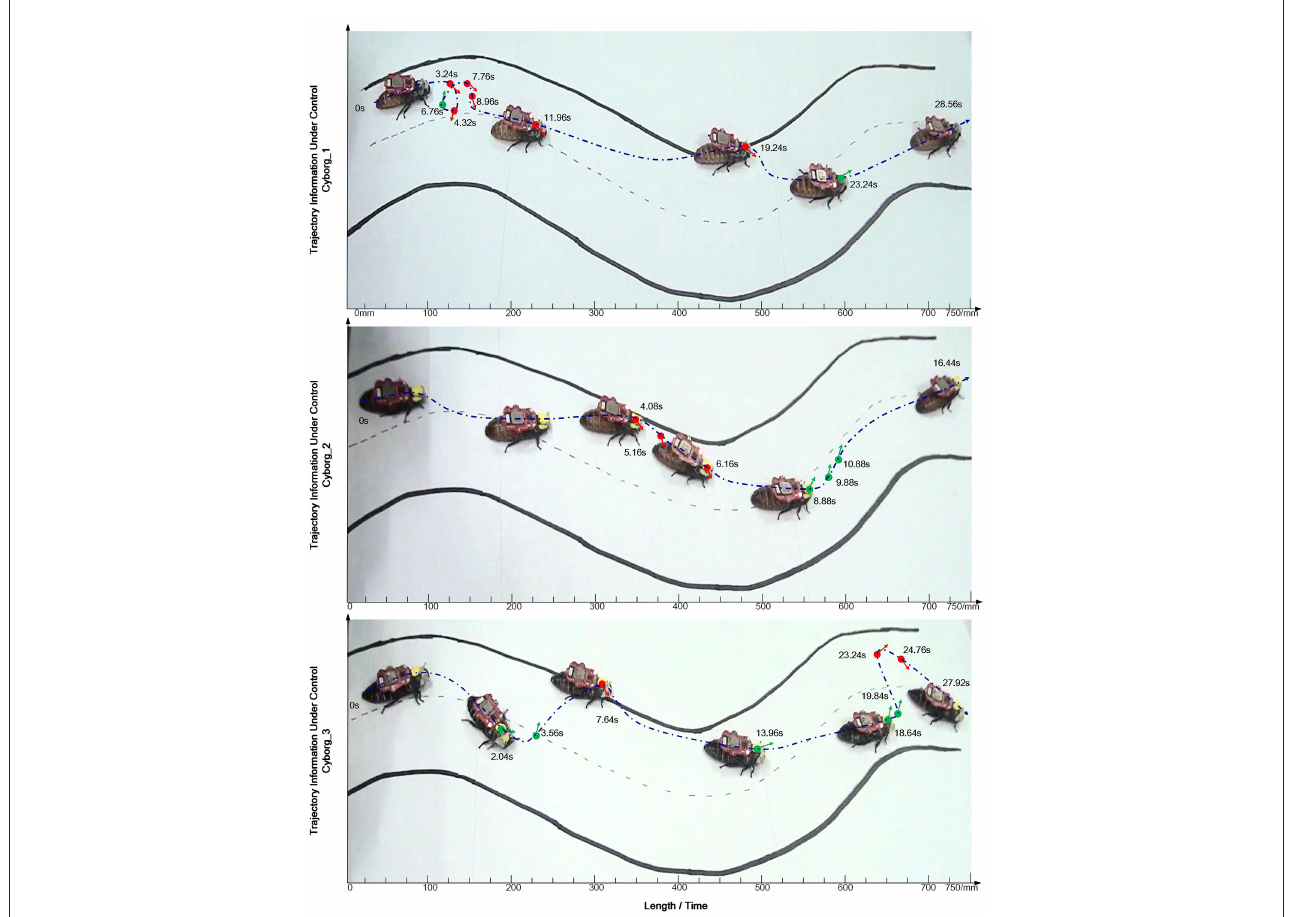
FIGURE2 The trajectory of a cockroach moving on the S curve showing time taken. A green dot indicates a left-turn command; a red dot indicates a right-turn command. Link to original source: https://journals.plos.org/plosone/article?id=10.1371/journal.pone.0150667.